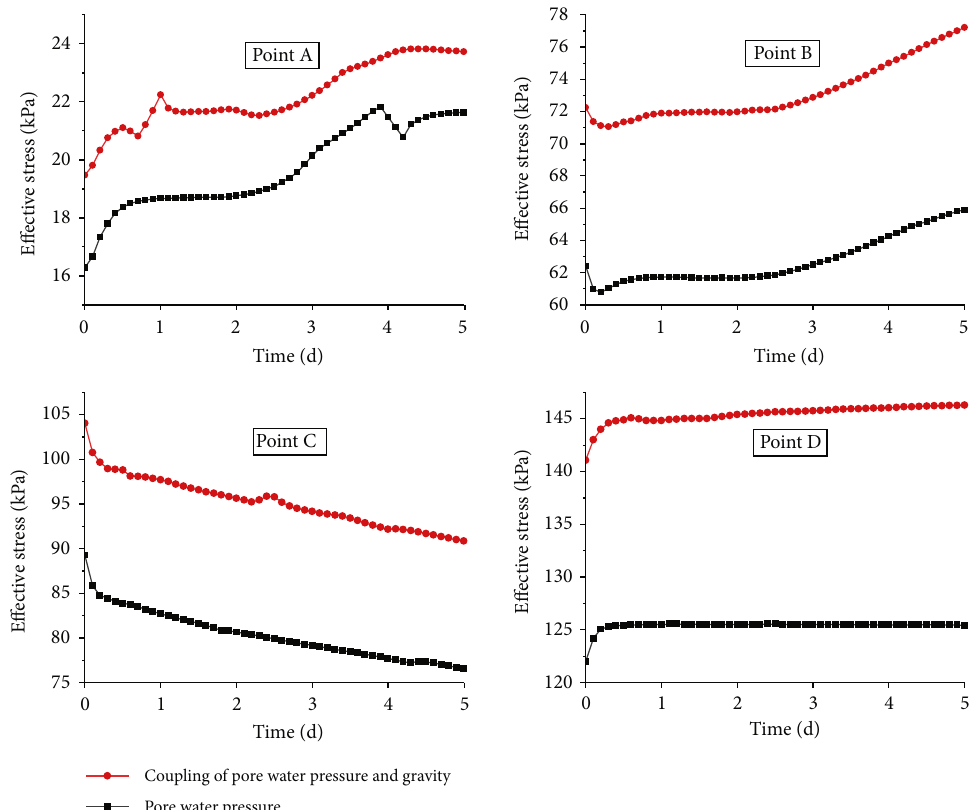
Figure 9: Comparison of e ff ective stress at each monitoring point varying with rainfall time in two cases.